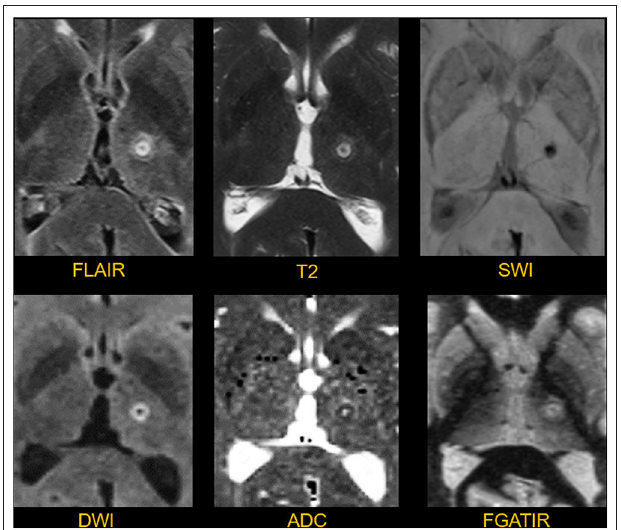
FIGURE 8 | Appearance of a thalamic lesion on postoperative day 1. The lesion in the left thalamus is manifest as a T2/FLAIR spherical hyperintense focus with a diameter of about 6mm. There is hemosiderin clearly shown in the susceptibility weighted image (SWI). There is a rim of restricted diffusion with a core of facilitated diffusion shown on the DWI and ADC images. The FGATIR sequence shows the relationship between the lesion, thalamus, and adjacent internal capsule.